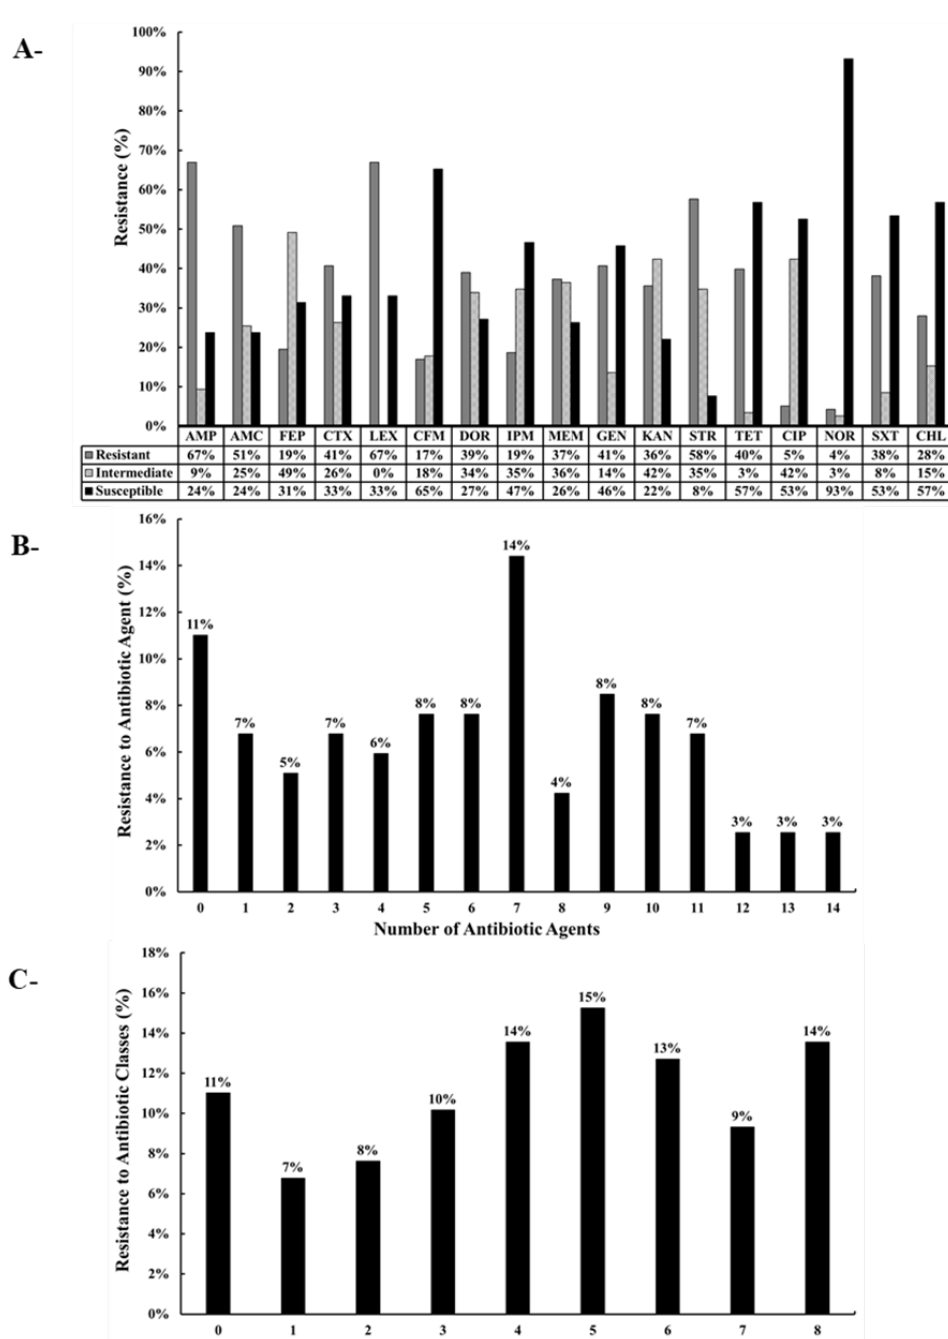
Figure 2. Hierarchical clustering of 118 E. coli isolated from Akkawi cheese in Lebanon. The isolate labels (IDs) refer to the associated cheese sample and the isolate number (if more than one E. coli was isolated from the same cheese sample). For example, [B-1] indicates that E. coli isolate #1 that was retrieved from Akkawi sample B. Squares in red represent resistance while those in black and green indicate intermediate resistance and susceptibility, respectively. The clusters are represented by the letter C.